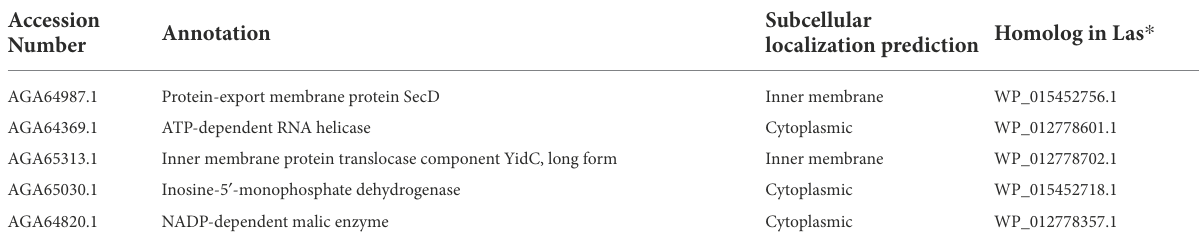
(Table 3) including porin AGA65052.1, 25 kDa outer-membrane immunogenic protein precursor AGA65143.1, D-alanyl-D- alanine carboxypeptidase WP_051012132.1, homoserine dehydrogenase AGA64434.1, thioredoxin C-1 AGA65357.1, and two proteins with unknown function AGA64557.1 and AGA64826.1. These seven proteins were predicated to be in the outer membrane (2), inner membrane (1), extracellular (1) and cytoplasmic (2) compartments. Among the 7 OMV proteins of Lcr identified by LC–MS/MS, 5 have homologs in Las